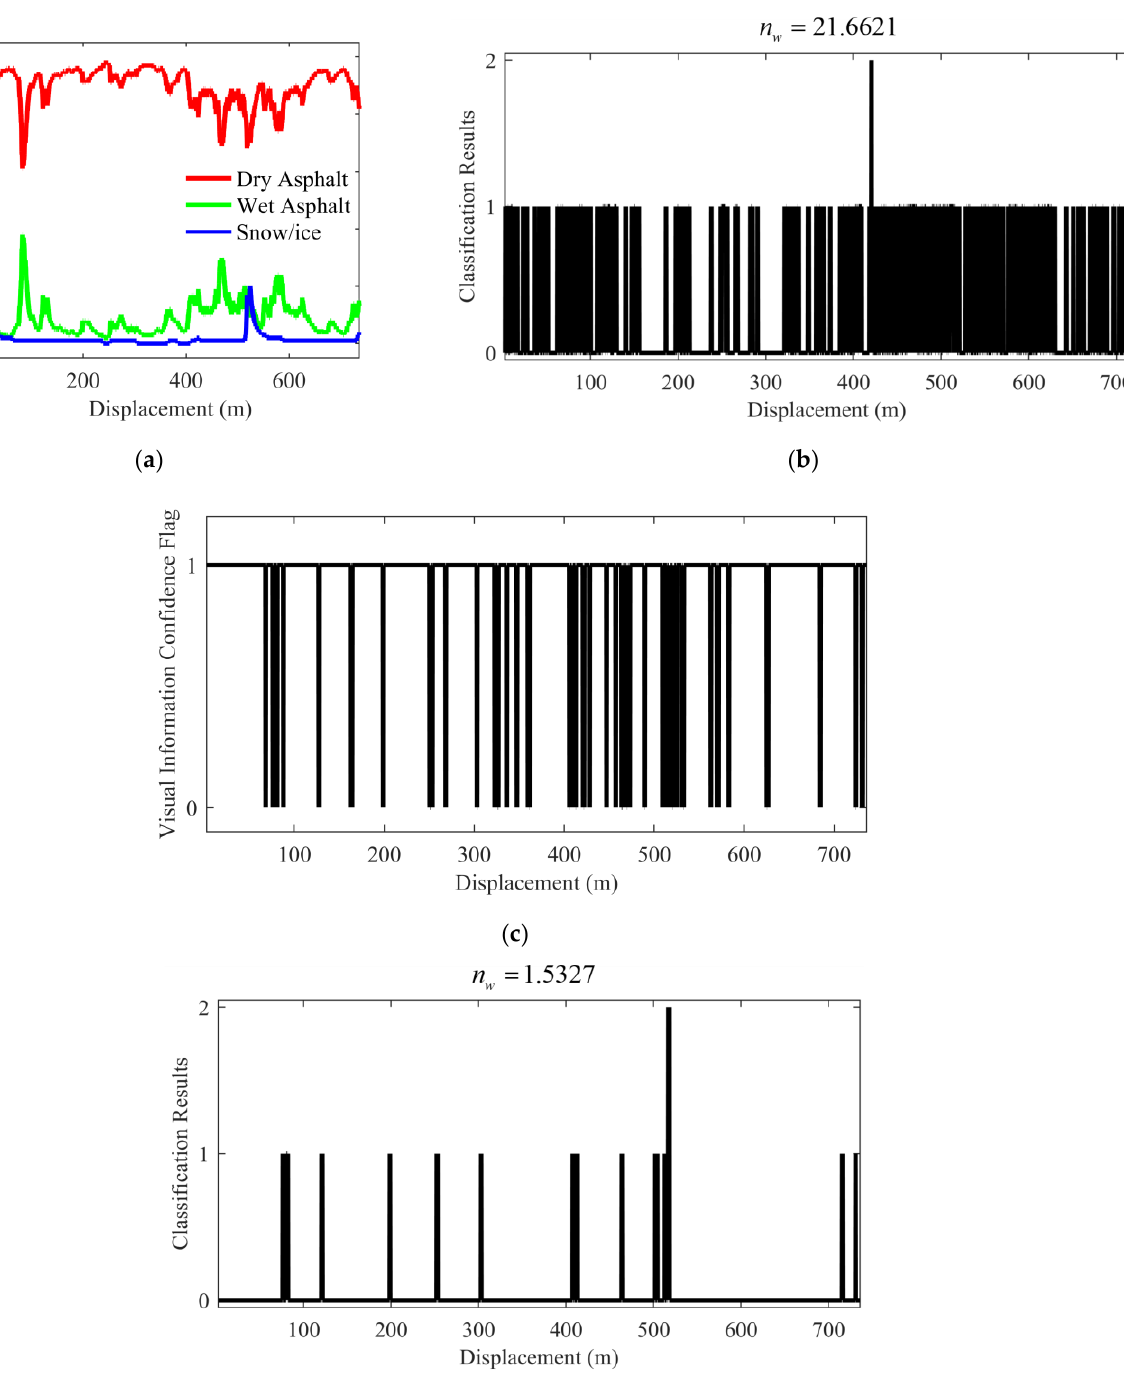
Figure 13. Test results under the normal scenario (left front wheel). ( a ) Evidence weight distribution; ( b ) Classification results of the IE based on the voting strategy; ( c ) Visual information confidence flag of the IFE; ( d ) Classification results of the IFE. (“0”, “1” and “2” represent dry, wet and snow/ice asphalt road, respectively.).